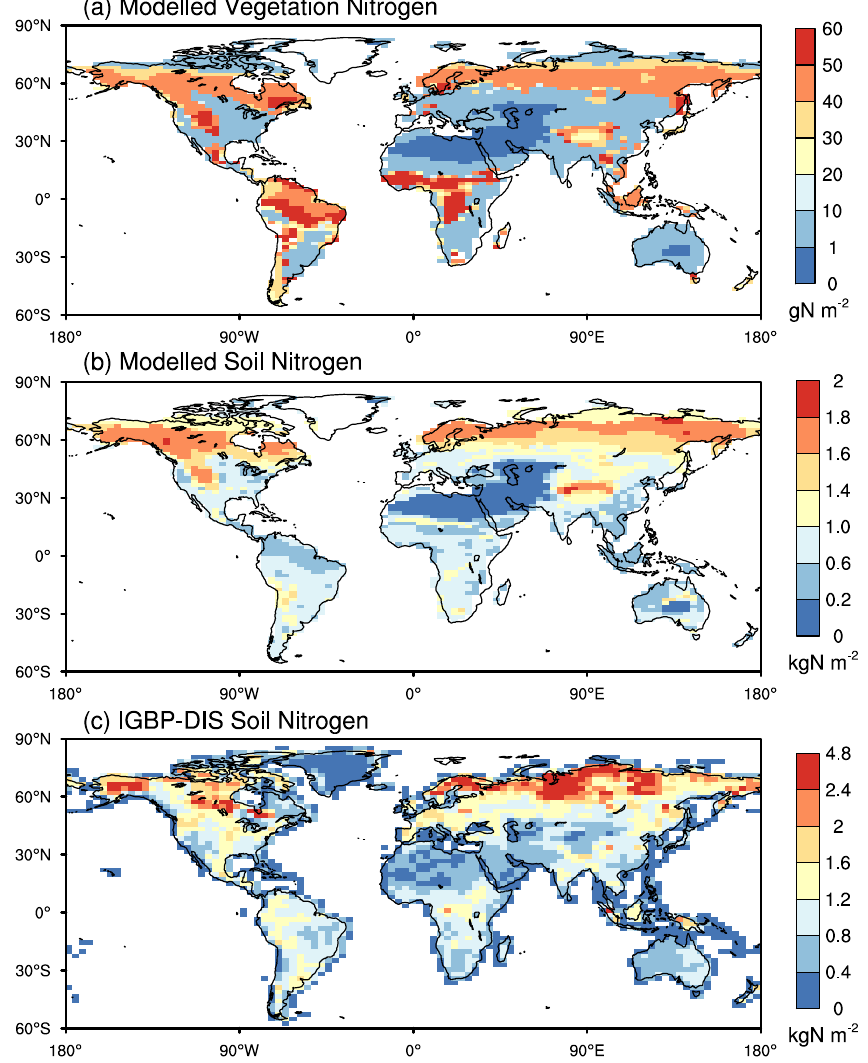
Fig. 2. Mean 1980–1999 nitrogen content in vegetation (a) and soil plus litter (b) simulated by UVic-CN and soil nitrogen content as given by the IGBP-DIS data base (Global Soil Data Task Group, 2000) (c)